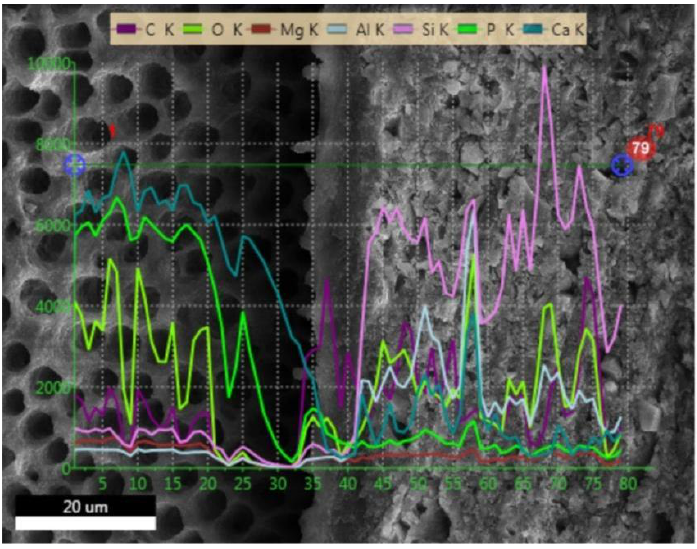
Figure 8. EDS line scan signals of individual elements present at dentin-resin interface obtained for Prime&Bond One Select applied twice in 40 s (group 2A40).